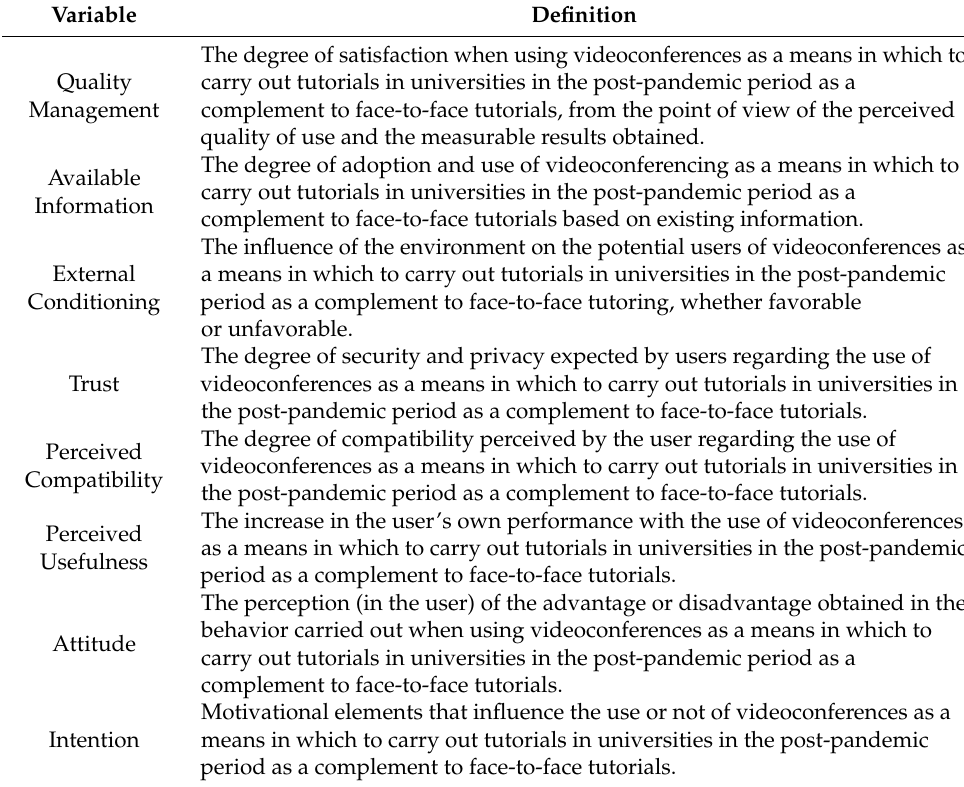
Table 1. Motivational factors: component concepts of the fuzzy cognitive